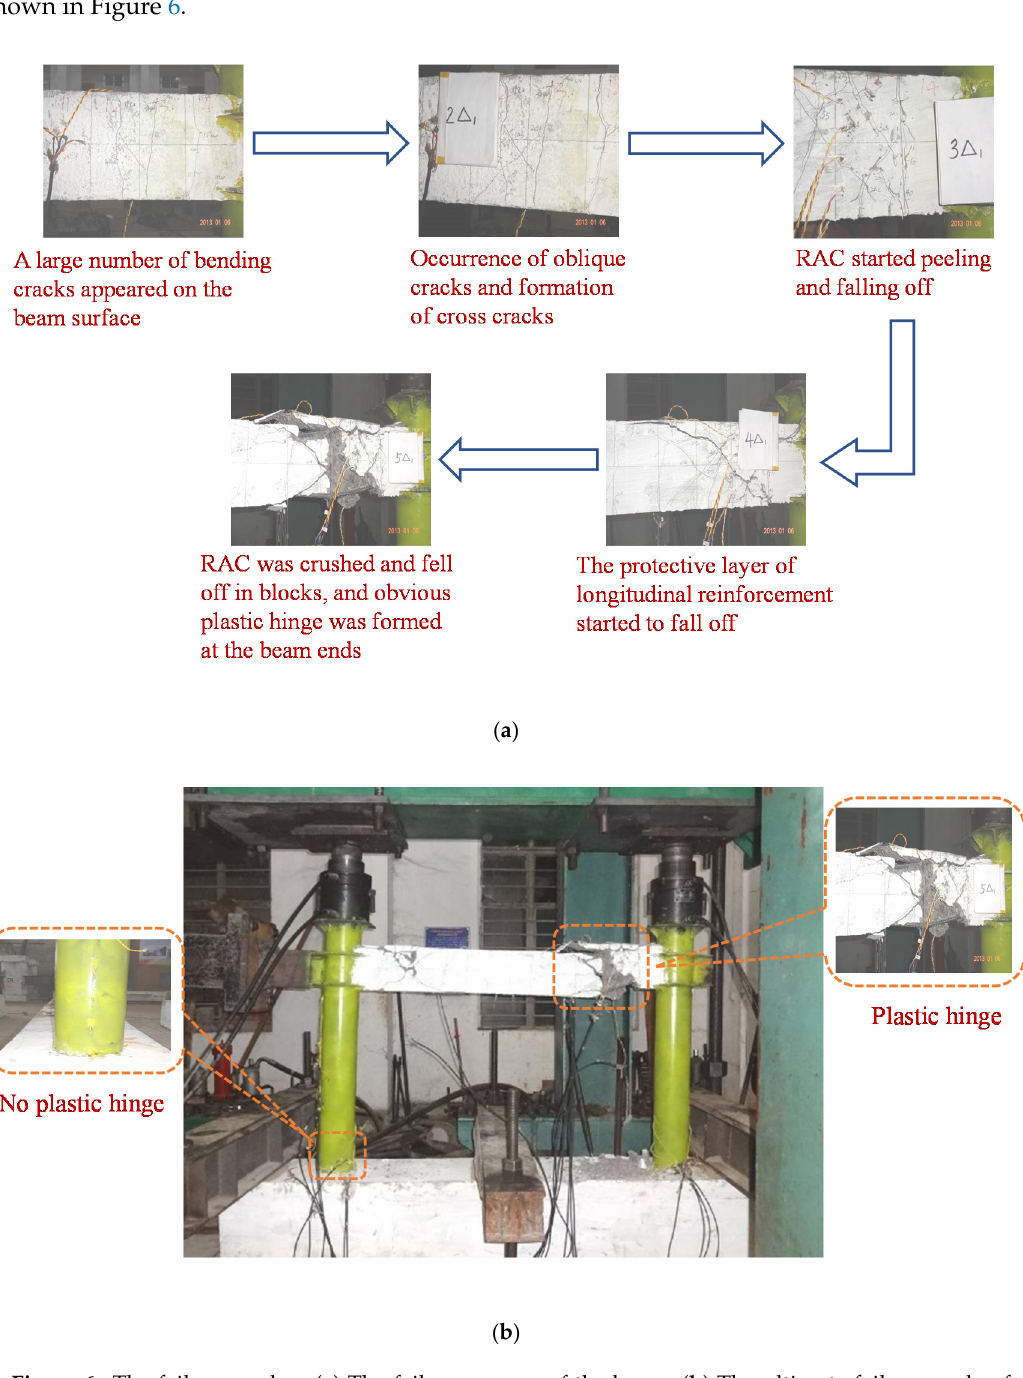
Figure 6. The failure modes. ( a ) The failure process of the beam; ( b ) The ultimate failure mode of the frame.